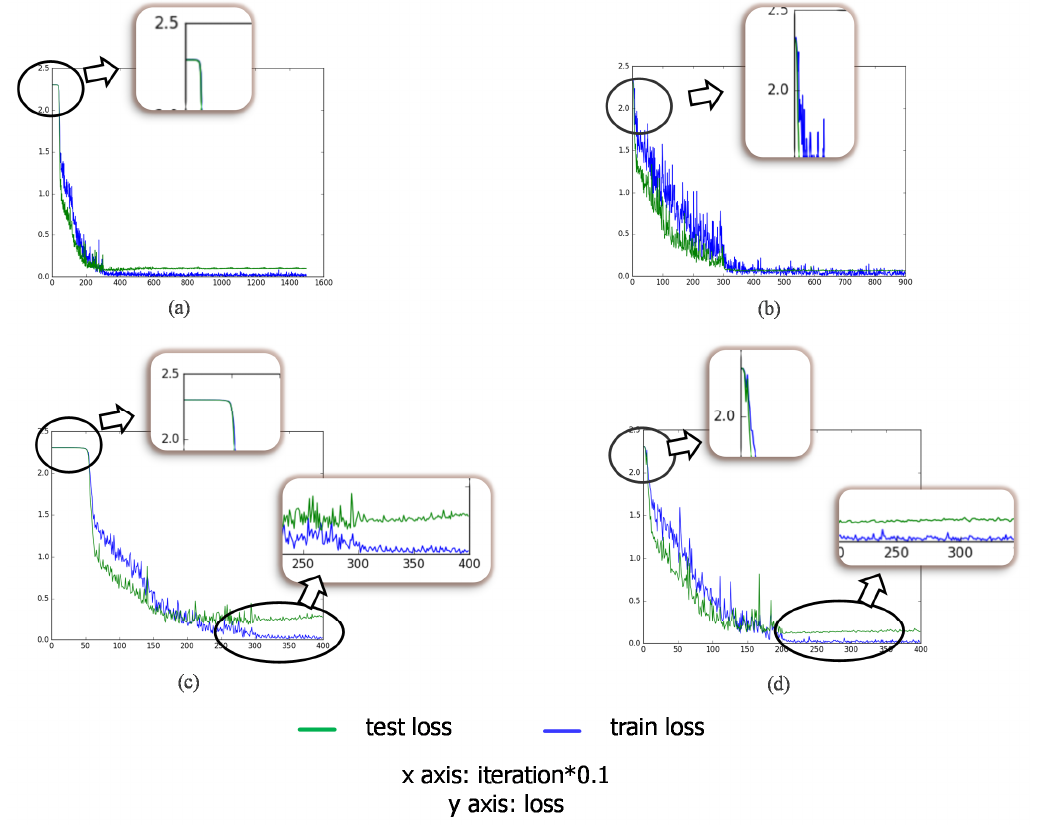
Figure 14. Testing loss curve during training. ( a , b ) the testing curve of baseline and transfer learning with 200 training images per category; ( c , d ) the testing curve of baseline and transfer learning with 50 training images per